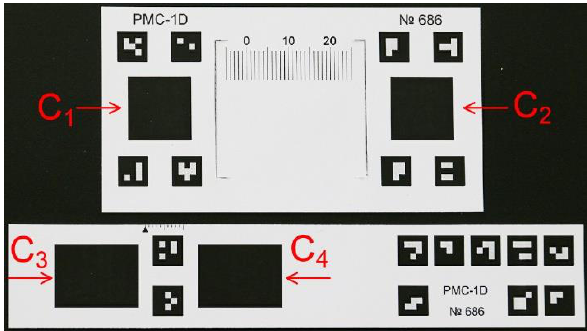
Figure 3. Wide and narrow marker plates with the designation of measuring areas.